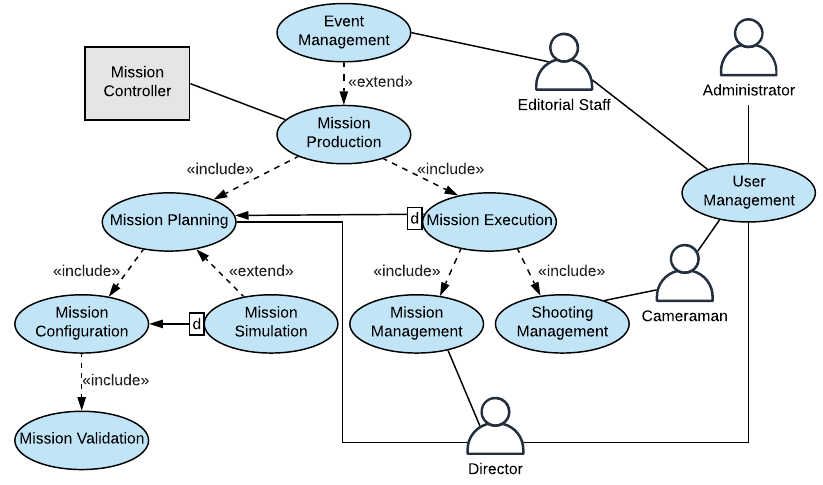
Figure 2. High-level use case diagram of the